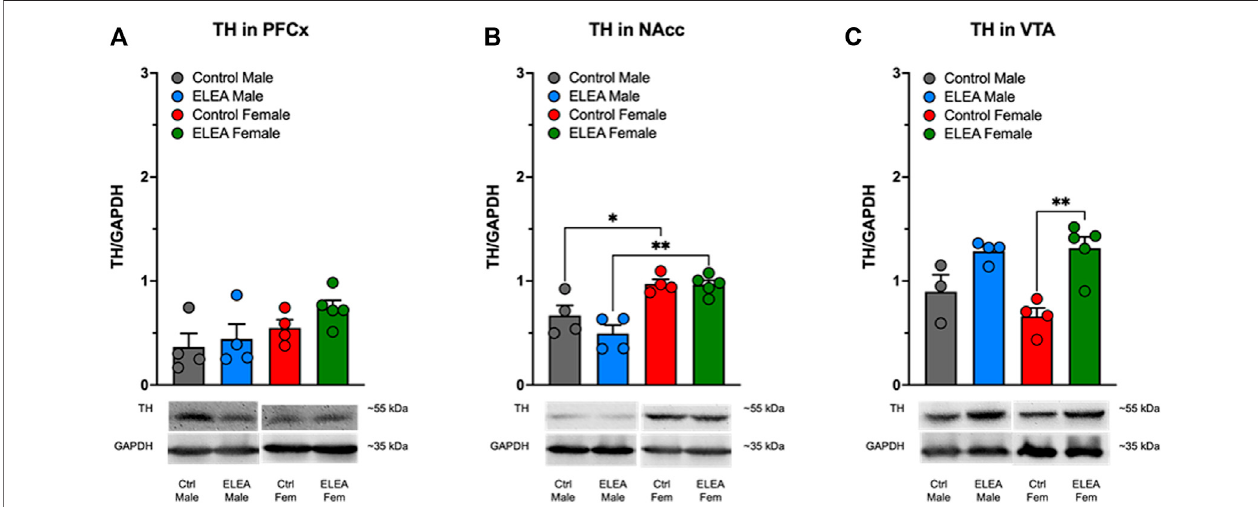
FIGURE7| EffectofperinatalantibioticexposureonTHproteinlevelsofthemesocorticolimbicdopaminergicsystem.Earlylifeantibioticexposurehadnoeffecton TH expression levels in PFCx (A) . Both control and antibiotic exposed females had higher TH protein levels than their male counterparts in NAcc (B) . Perinatal antibiotic exposureincreasedTHexpressioninVTAofmaleandfemalerats (C) .(Controlmale, n =4;ELEAmales, n =4;controlfemale, n =4;ELEAfemale, n =5;*= p < 0.05;**= p <